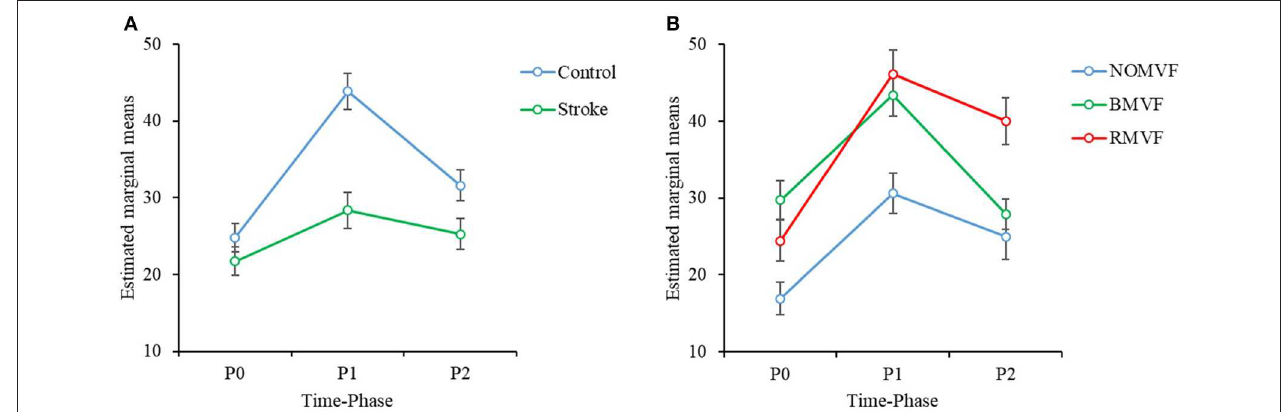
FIGURE 3 | Three-way repeated-measures analysis of variance was used to examine the effects of group, test condition, and time-phase on the event-related desynchronization (ERD) areas (%) in the mu band. (A) There is a statistically significant interaction effect between group and time-phase in the IH brain area (C3). (B) There is a significant interaction effect between the test condition and time-phase in the CH brain area